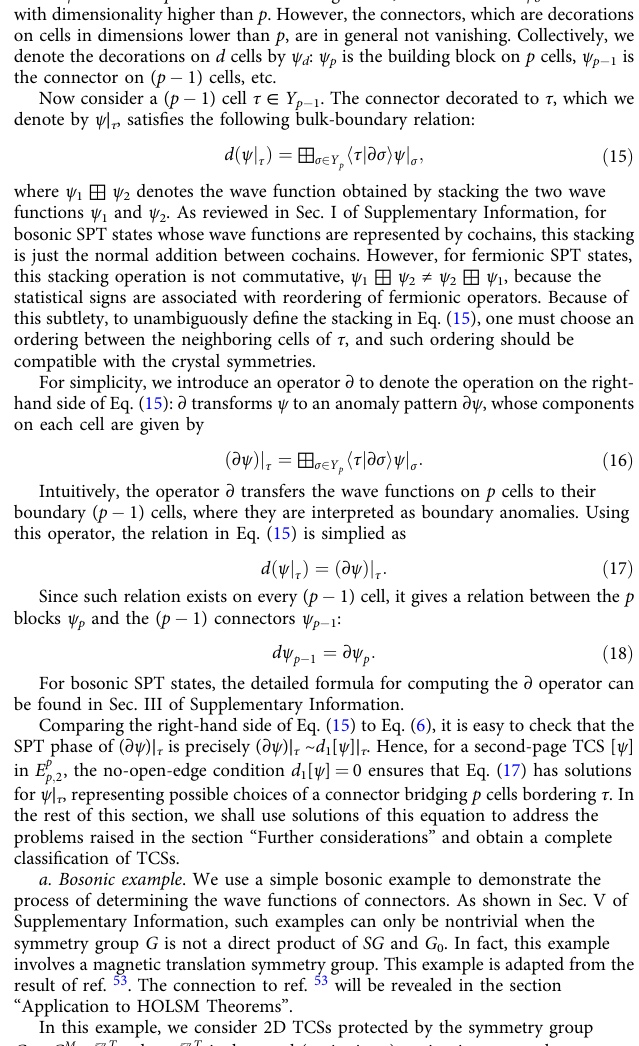
Fig. 2 Illustration of no-open-edge condition and bubbling equivalence. a One symmetric assembly in E 2 shows the cross section of a unit cell that is perpendicular to the z direction. The arrows show the orientation of 2- and 1-cells. This assembly fails the no- open-edge condition. b The evolution of assembly in ker d 1 for space group Pm in a fermionic system. The 2-cells are decorated with Chern insulators, the Chern numbers of which are indicated. This state is equivalent to an assembly in E 2 (inward) thin arrow means that the Chern number on the associated boundary is + 1 (